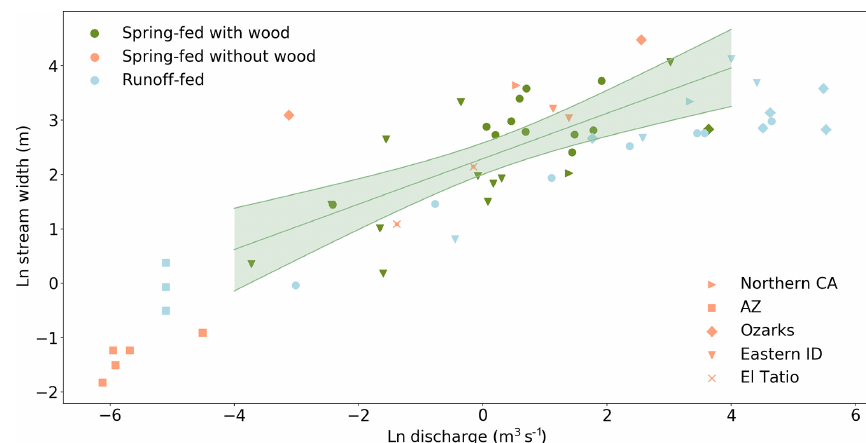
Figure 5. Relationship between bankfull discharge (or 1.25-year flow as an approximation to bankfull discharge for some runoff-fed streams marked in Table 1) and stream width plotted on a ln − ln plot for spring-fed streams with wood (dark green), spring-fed streams without wood (orange), and runoff-fed streams (light blue). The line of best fit for spring-fed streams containing wood is shown ( w = aQ b , a = 14 . 0 ± 2 . 71 and b = 0 . 27 ± 0 . 09); 95% confidence interval for the fit is shaded. Stream types are denoted by color, as shown in the top left, and locations are denoted by shape, as shown in the bottom right. Runoff-fed streams are fit by a similar, although potentially smaller value of a = 9 . 12 ± 3 . 81, indicating that runoff-fed streams may be narrower than spring-fed streams at the same bankfull discharge. All runoff-fed streams contain wood, and no runoff-fed streams without wood were available for comparison.